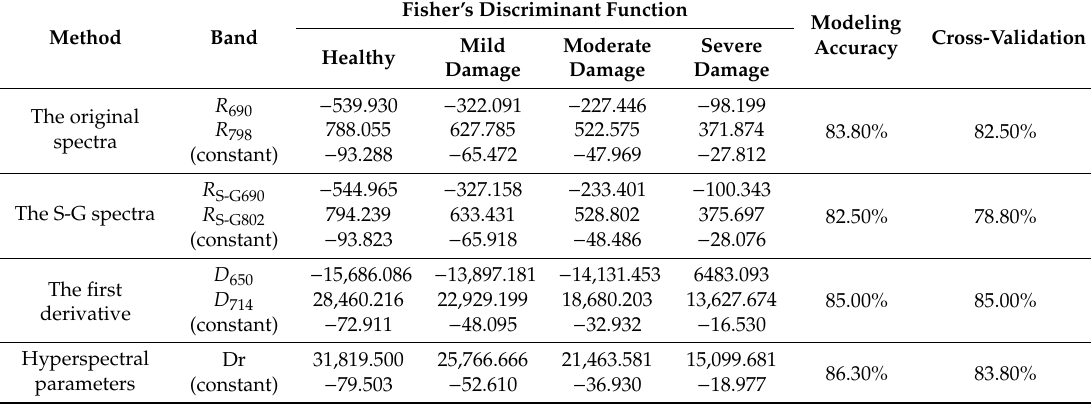
Table 9. Stepwise discriminant analysis results for di ff erent spectral processing methods. Stepwise discriminant analysis was carried out on the results of four spectral data processing methods and the damage degree. The discriminant coe ffi cient of each degree of damage is listed in Fisher’s discriminant function. Constant represents the constant term in the discriminant function.